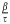
Distribution of rewards offered by low-productivity individuals to high-productivity individuals in the last generation of an 8,000-generation simulation, for different levels of partner choice cost (higher values of βτ represent lower costs).High-productivity individuals’ relative contribution compared to low-productivity individuals is 0.66, so the dashed line represents the expected equitable distribution. This distribution can only be reached when partner choice is not costly (βτ is high).